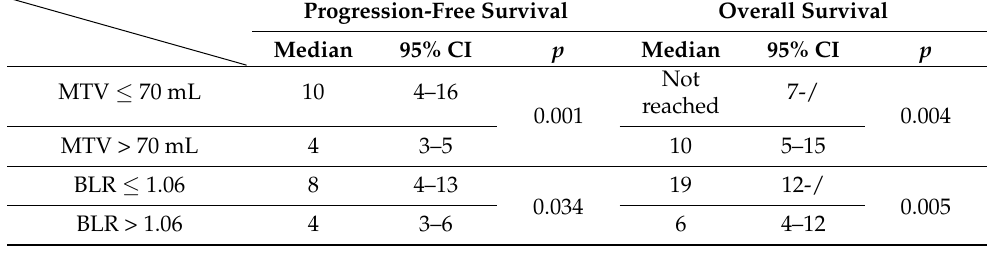
Table 2. Median progression-free and overall survival according to MTV and BLR cutoff values. CI = confidence interval, MTV = metabolic tumor volume, BLR = bone marrow to liver ratio.